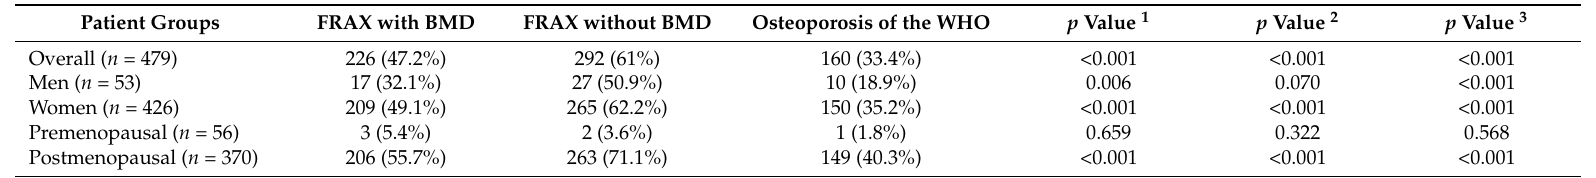
Table 2. Candidates for pharmacological treatment using the FRAX criteria with and without BMD and the WHO osteoporosis criteria in patients with rheumatoid